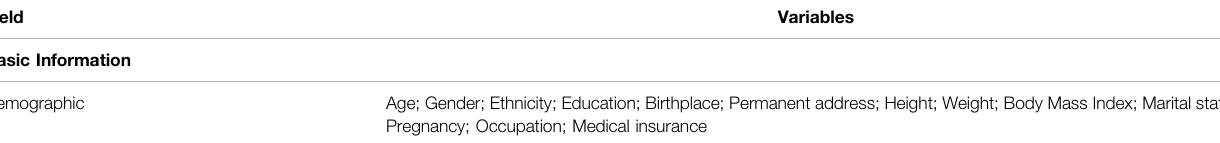
TABLE 1 | Main variables registered in CASES-TCM